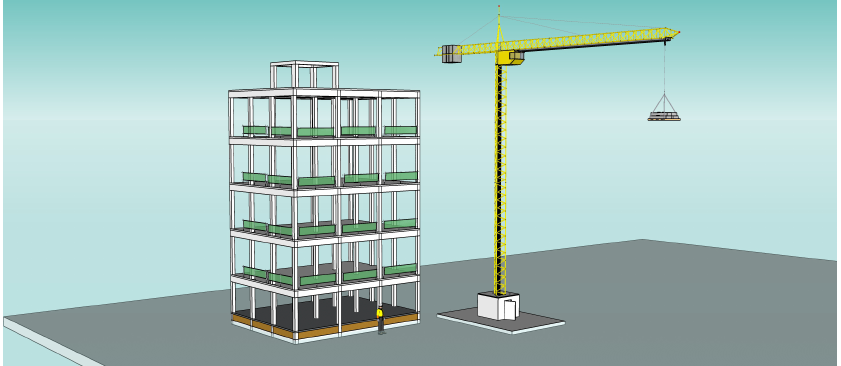
Figure 4. Visual example of material loading tasks: Low risk.